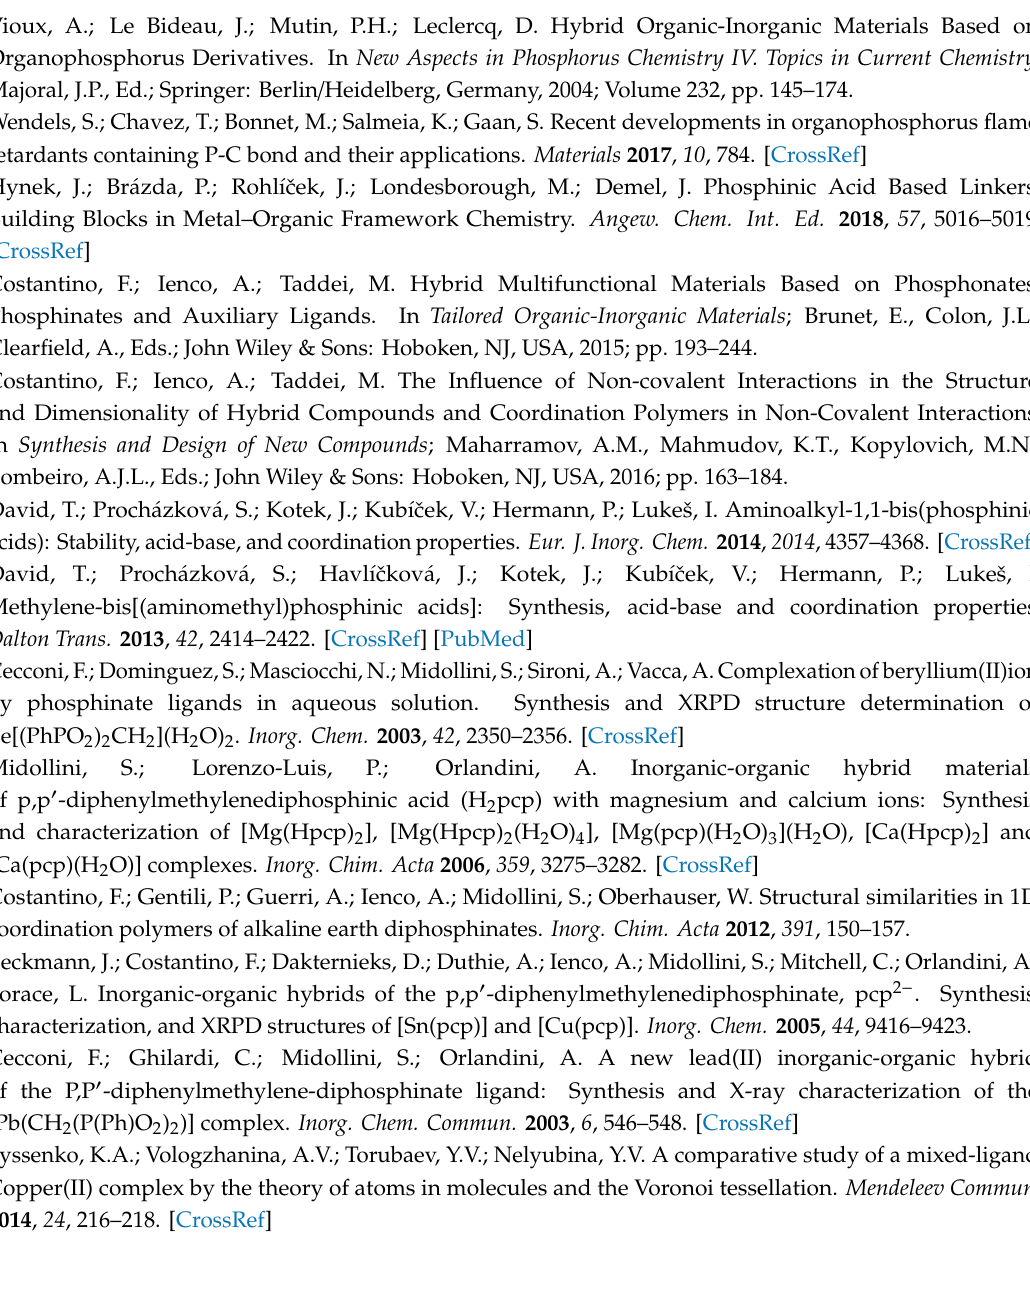
Figure S1: Comparison of the calculated and experimental X-ray pattern for 1 ; Figure S2: Temperature-dependent X-ray powder di ff raction patterns for phase 2